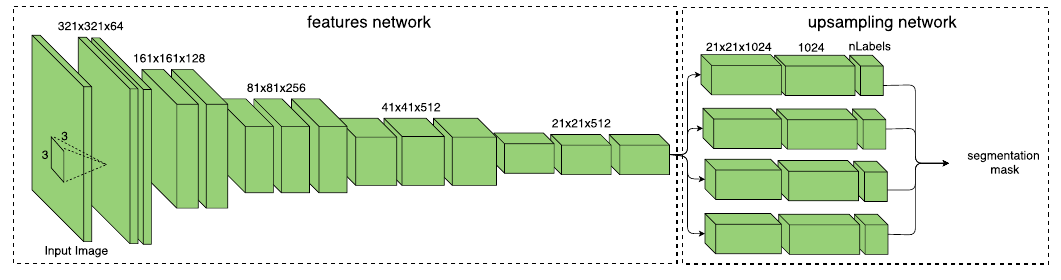
Figure 4. Semantic segmentation